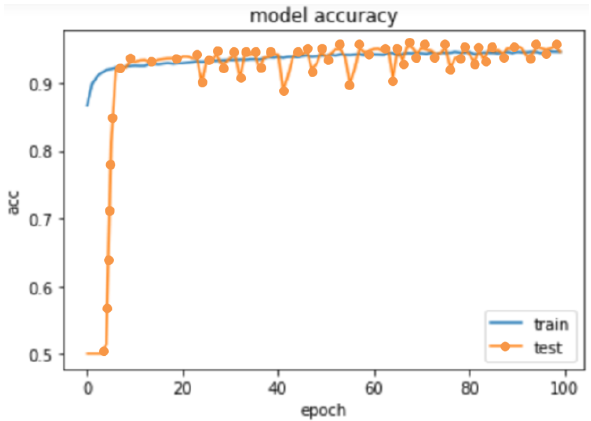
Figure 5. The training accuracy quality of the double-layer ANN for the two classes for the set of indicators from the ATC profile widths at levels of 10%, 50%, and 90% of the maximum amplitude value and maximum amplitude.